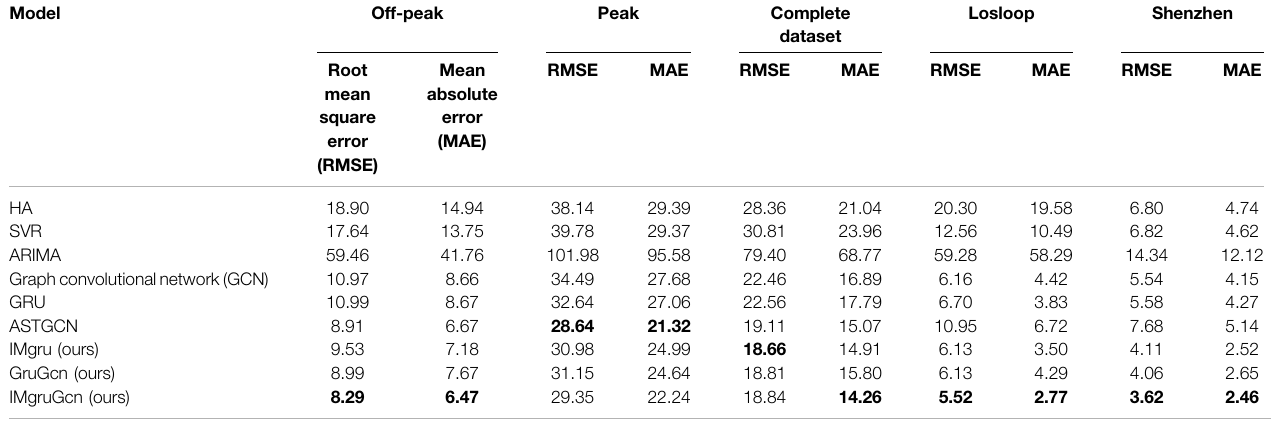
The bold values are represent the best prediction result of all models.